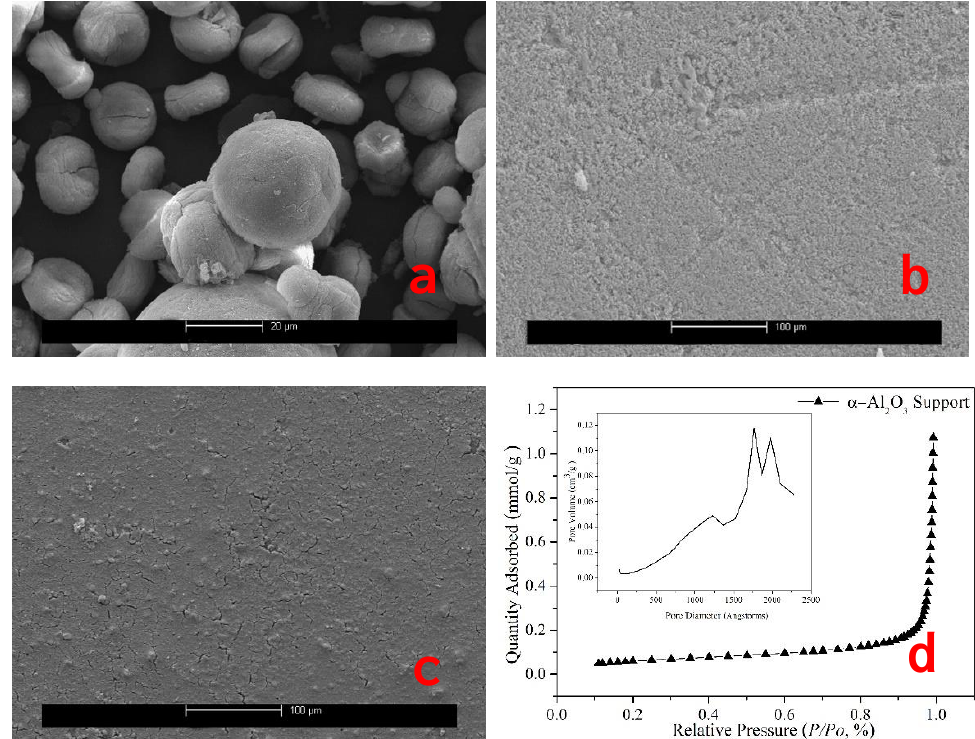
Figure 2. ( a ) SEM picture of the AlPO 4 -5 seeds powder, ( b , c ) SEM image of the α -Al 2 O 3 substrate and the AlPO 4 -5 seeds deposited on α -Al 2 O 3 substrate. ( d ) Nitrogen adsorption isotherm of α -Al 2 O 3 support. Inset is the pore size distribution obtained from the adsorption branch by the BJH method. The plus signs in Figure 3 reflect peaks arising from the α -Al 2 O 3 substrate, whereas the asterisks represent peaks originating from the AlPO 4 -5 layer. The usual peaks of the AFI framework structure may be easily observed in the XRD pattern, suggesting AlPO 4 -5 crystals on the α -Al 2 O 3